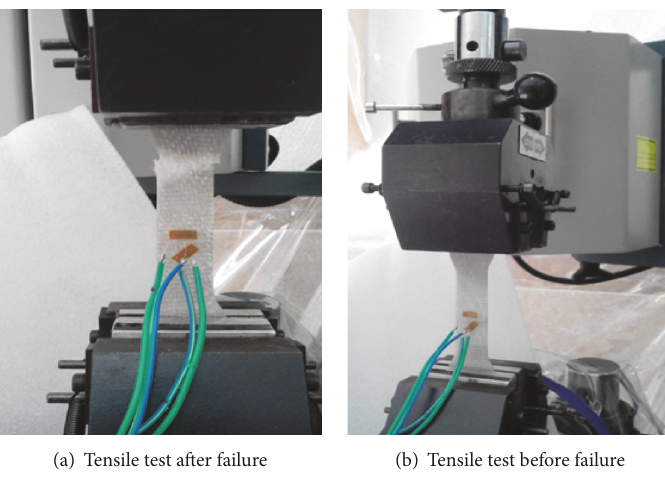
Figure 5: Tensile test done for glass/epoxy specimens. Table 6: Four determined elastic constants for the aluminum plate.